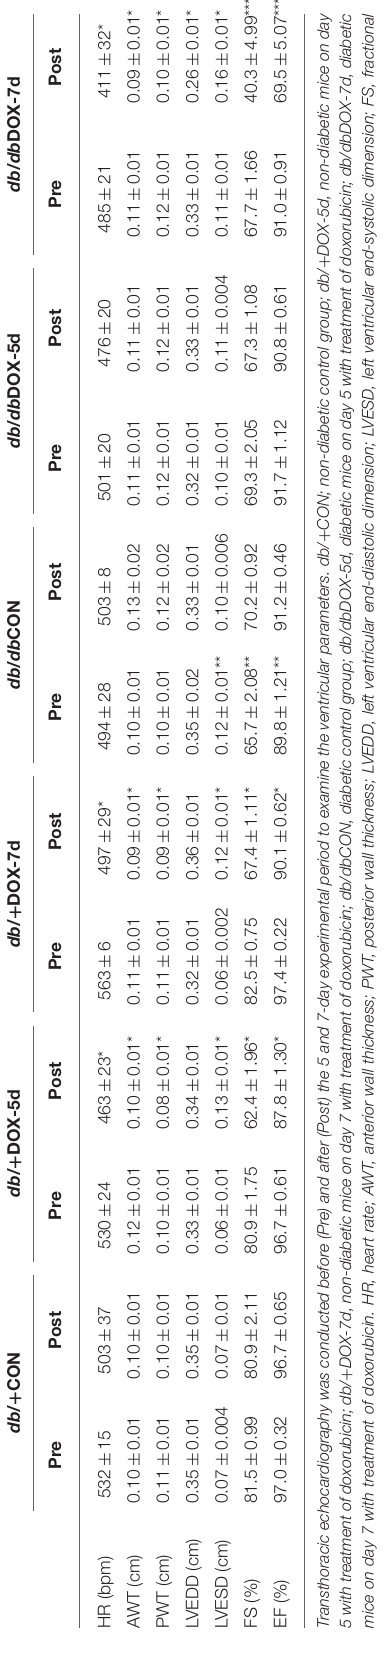
TABLE 5 | Body weight at baseline and following DOX treatment.